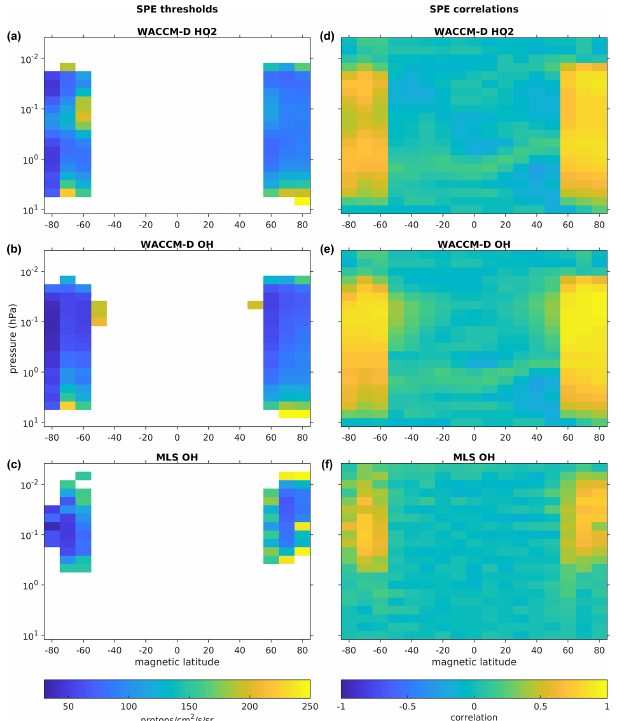
Figure 7. Nighttime SPE indicator thresholds (a–c) and corre- sponding correlations (d–f) . WACCM-D HO 2 (a, d) , WACCM-D OH (b, e) , and MLS OH (c, f) .